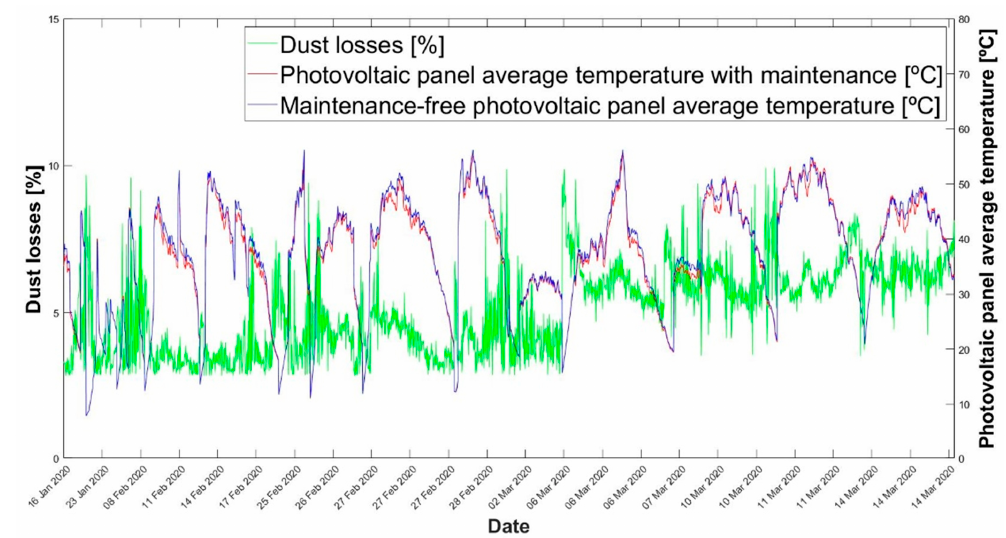
Figure 13. Variation in the production loss associated with dust and the average temperature of the photovoltaic panels during the measurement campaign.